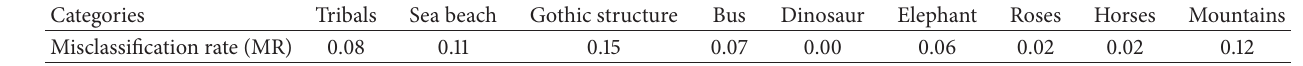
Table 1: Comparison of misclassification rate (MR) for the nine image categories.